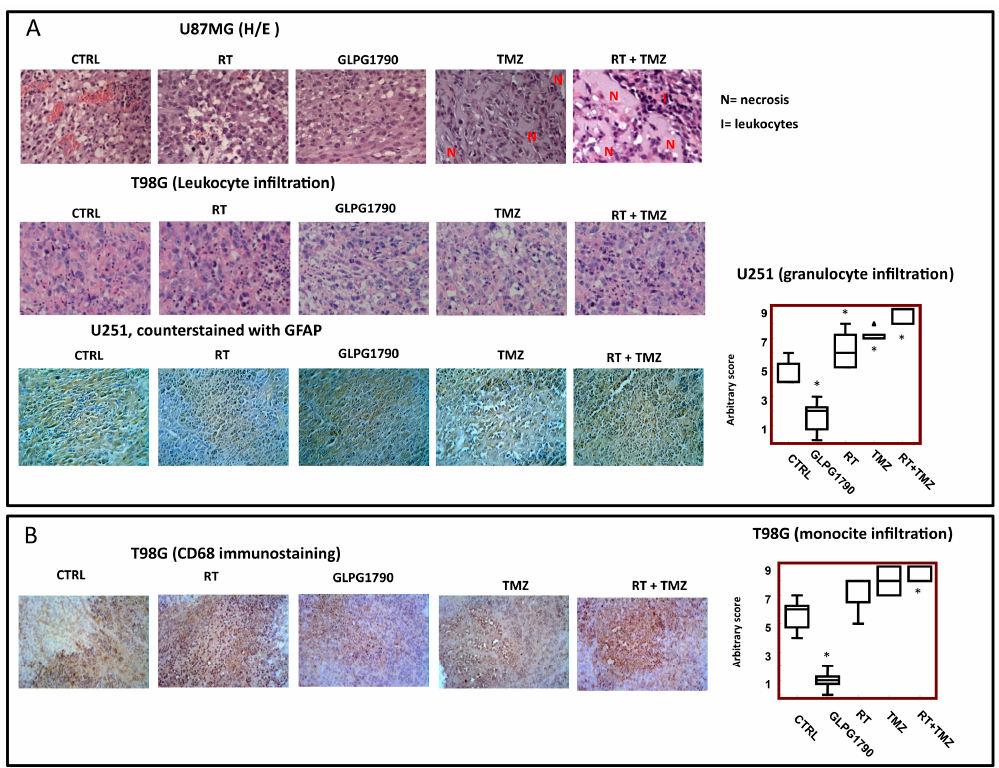
Figure 6. Tumour infiltration of inflammatory cells. ( A ) Infiltration of granulocyte (neutrophils and eosinophils) and ( B ) mono-nucleated blood cells (monocytes). Leukocyte infiltration was concentrated both along the front of tumour cell growth, as well as dispersed among the tumour cell sheets. * p < 0.05 vs. CTRL. Scale bar: 1 cm = 100 μ m.